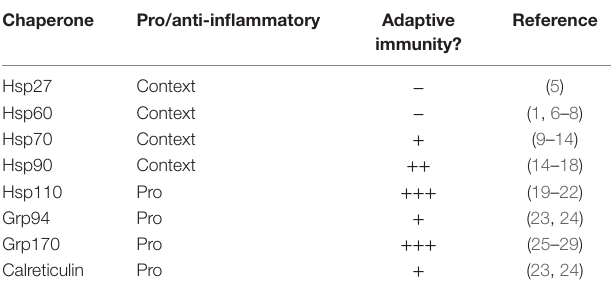
TABLe 1 | immune/inflammatory roles for extracellular chaperones.